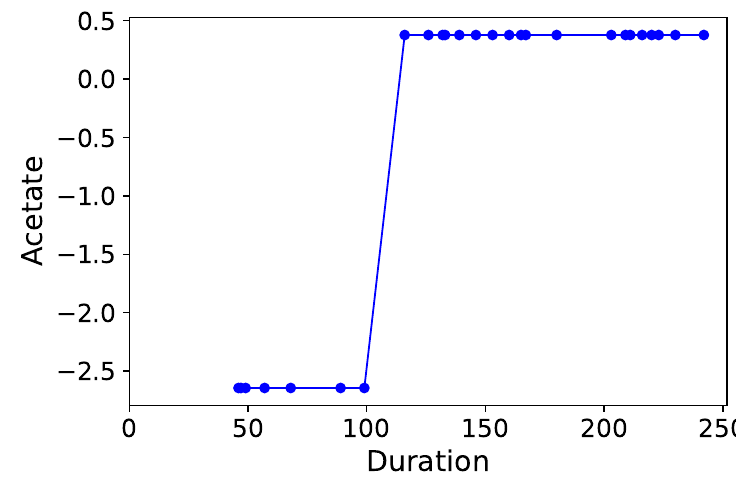
Figure A14. Normalized categorical carbon source (Acetate) for Reactor